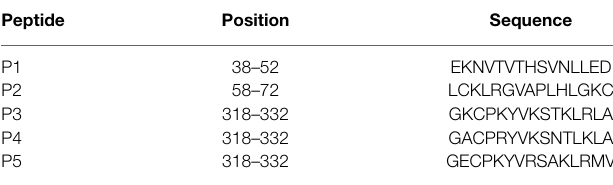
TABLE 1 | Sequences of the peptides tested against the scFv antibodies .